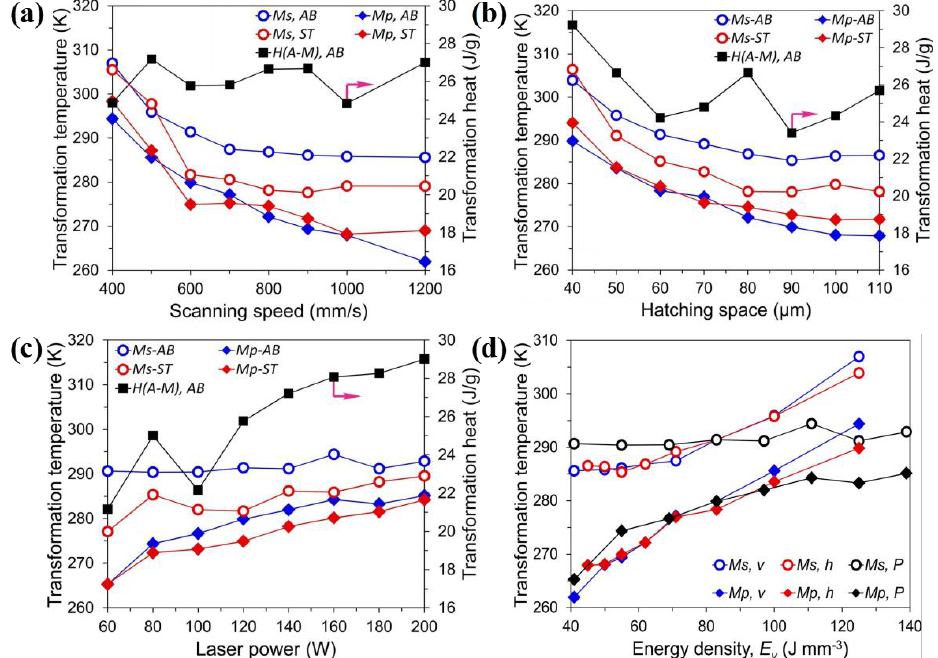
Figure 7. Influence of SLM processing parameters on phase transformation temperature ( a ) scanning speed; ( b ) scanning spacing; ( c ) laser power; ( d ) energy density [17]. speed; ( b ) scanning spacing; ( c ) laser power; ( d ) energy density [17].